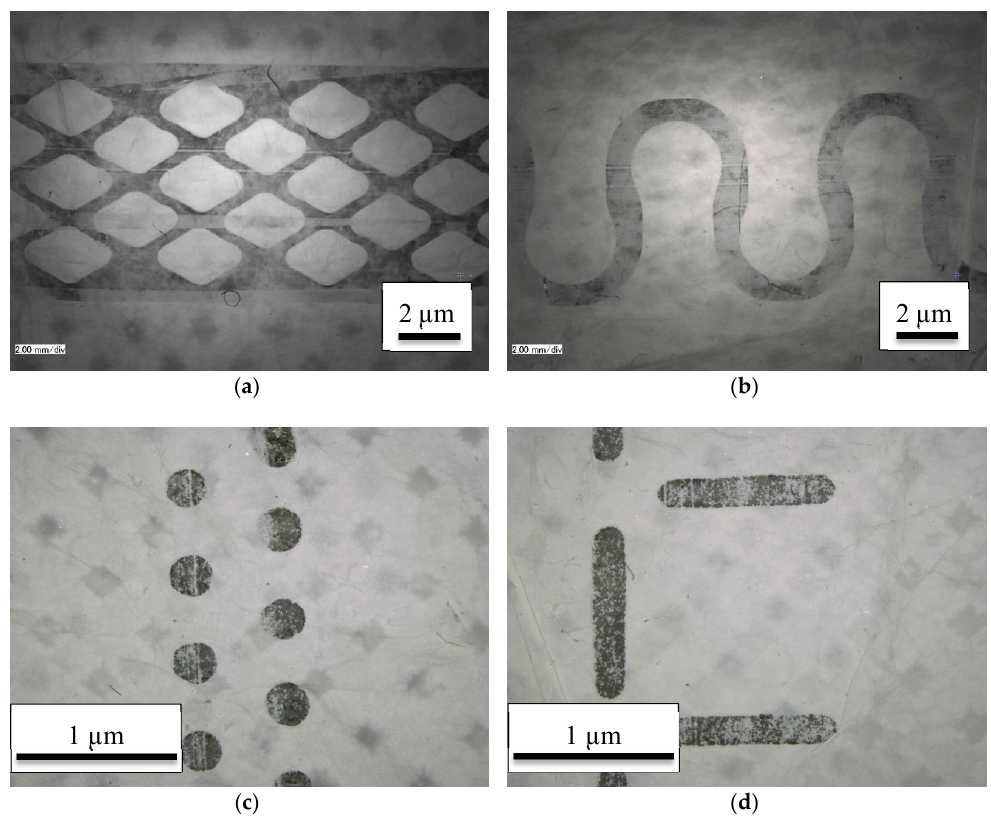
Figure 5. Microscopic images of the ultrasonic welding seams prepared with a pressure of 65% = 97.5 bar, a power of 750 W and different anvil wheels: ( a ) diamond (W 12904); ( b ) omega (W 13406); ( c ) point 2-rowed (W 11005); ( d ) T-stitch welding (W 13013). The scales differ due to the different seam widths.